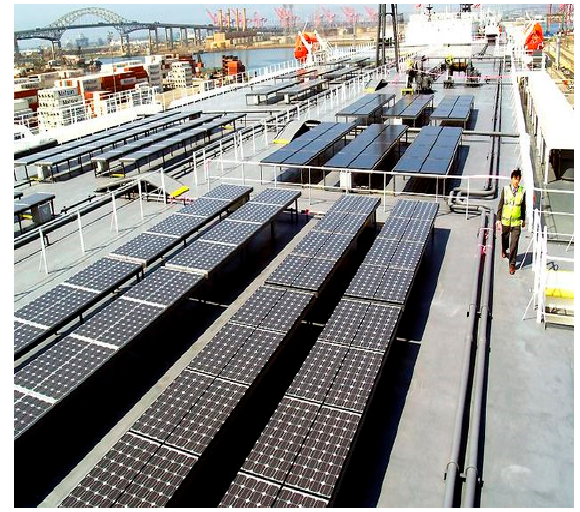
Figure 3. Installed solar panels, on Auriga Leader’s deck [45], Reprint with the written permission from the photographer Tom Anderson 2019.